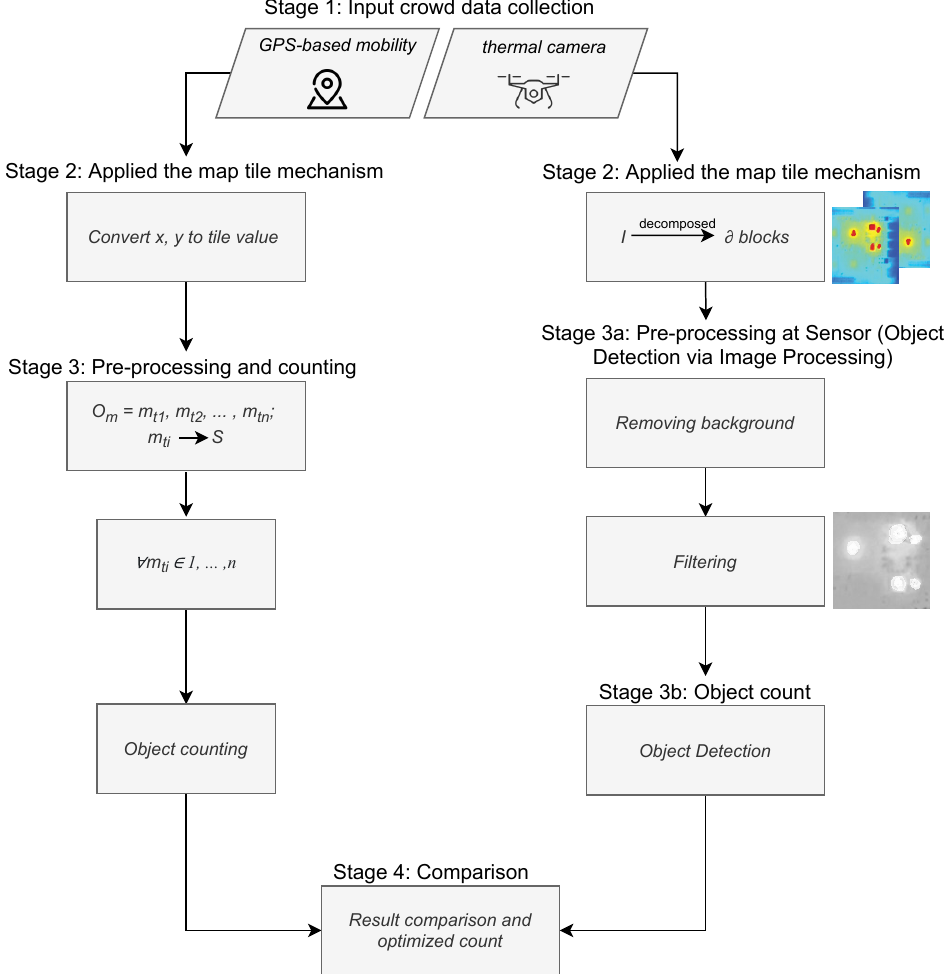
Figure 5. The schematic diagram of the proposed crowd mobility tracking and crowd size